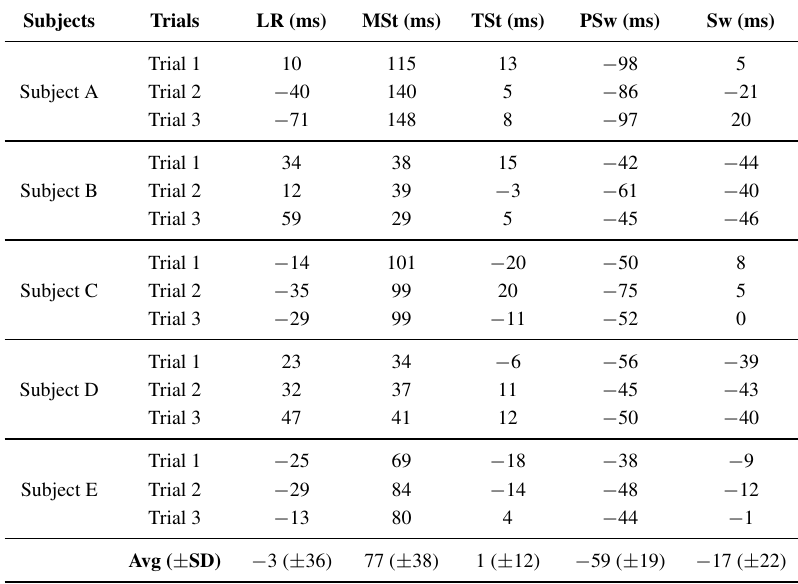
Table 4. Average duration of each estimated gait phase vs. Perry’s gait cycle (left cycles). Avg, average.